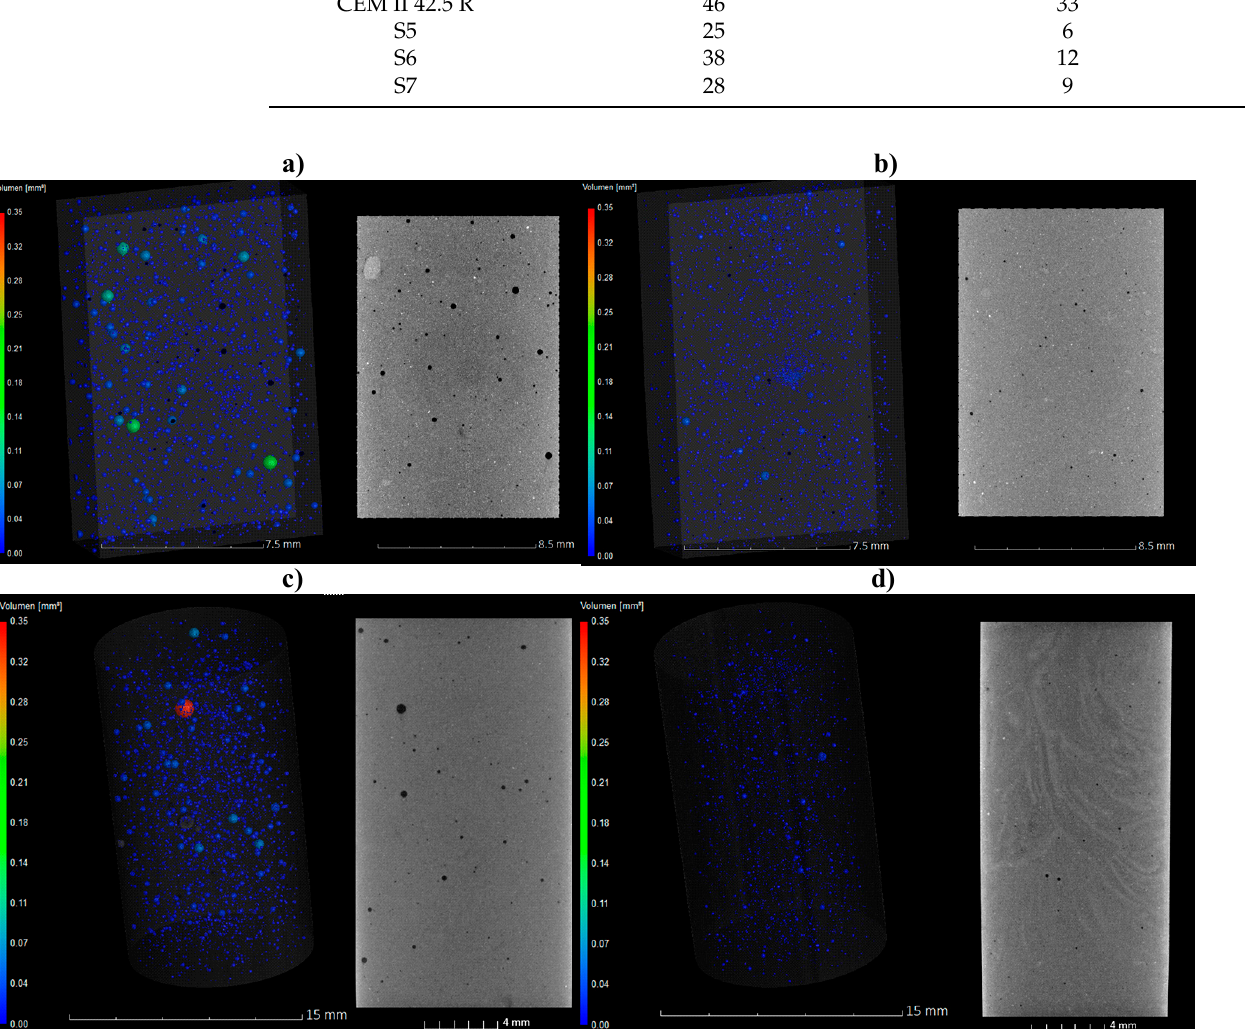
Figure 9. Evaluation of the fluidification properties through slump test of CEM II 42.5 R doped with and 1% bwoc of additives with a w/c = 0.5 (DIN EN 197-1). 3.9. Strengthening Behavior by Means of Ultrasonic Investigations The starting and final points of setting obtained with the Vicat test (see Section 3.4) correspond to an ultrasonic velocity of 1417 and 1794 m/s, which is shown in Figure 10. The length of the delay periods of the synthesized products are then investigated: the only raw CMC never sets after 5 days, the samples S2, S3 and S4 generated a serious retardation effect until more than 36 h. Reducing the Mw of the samples at high temperature, with the samples S5, S6 and S7 the initial and final setting times were shorter than the cement-only